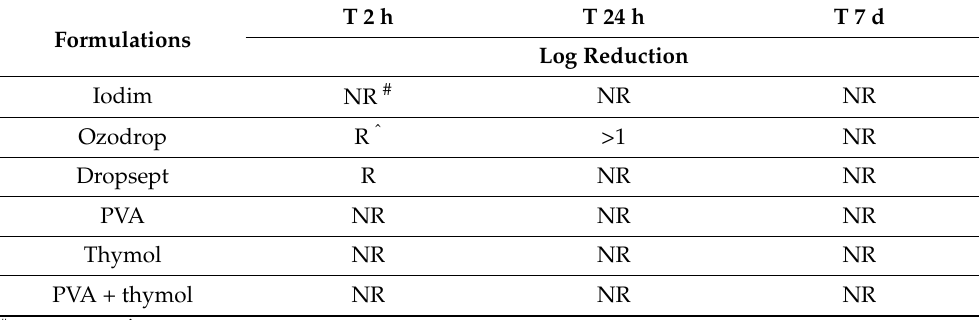
Table 6. Challenge test on S. aureus .